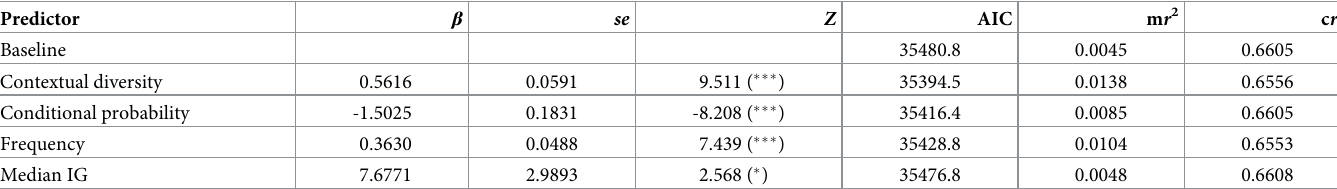
Table 1. Logistic mixed-effect models for single predictors—cosine